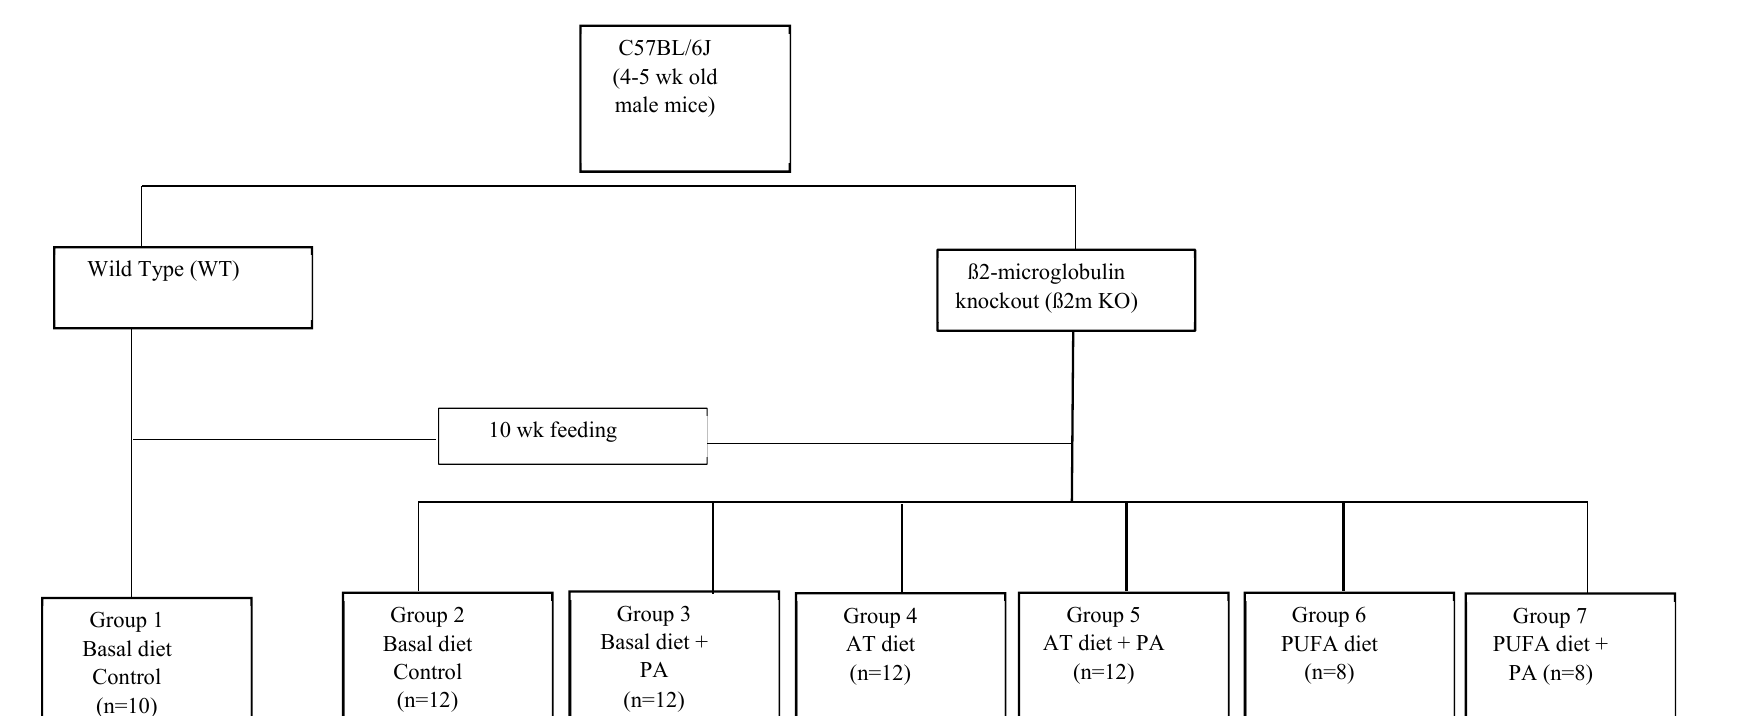
Figure 1. Study Figure 1. Study Design.